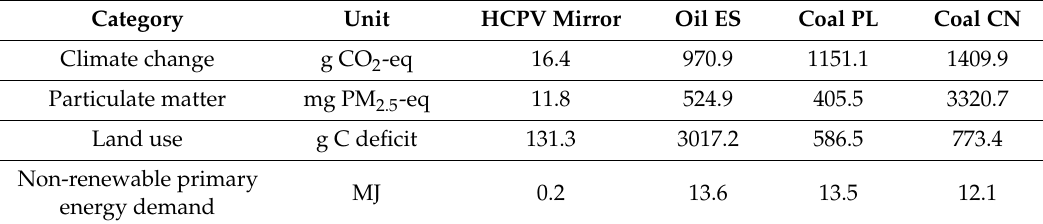
Table 3. Environmental impact assessment results for 1 kWh stemming from di ff erent energy sources. The first three categories are obtained with the ILCD Midpoint + 2011 method and the last one with the Cumulative Energy Demand version 1.0.9 [69] method. ES, SE, PL, and CN represent, respectively,